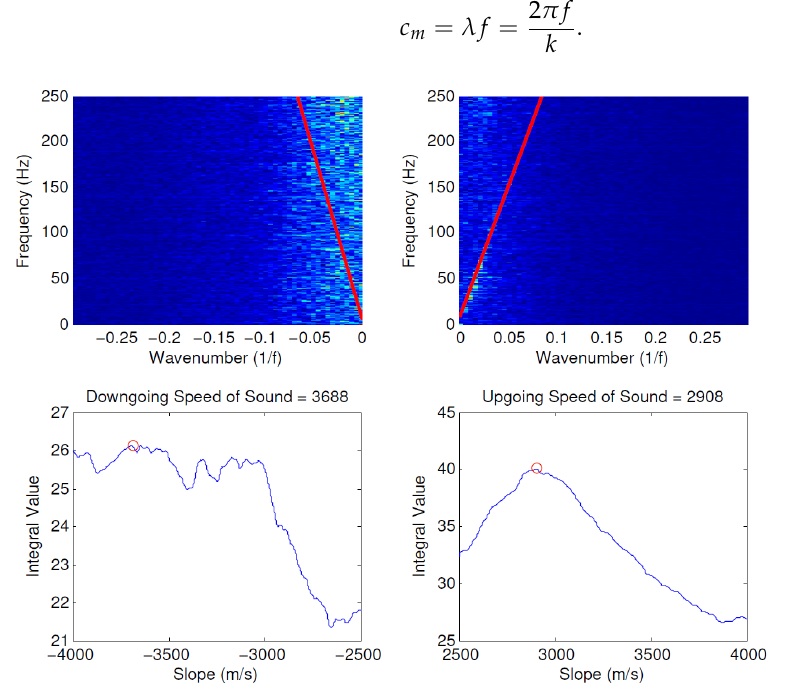
Figure 8. Comparison of the speed of sound between a clear line image ( left ) and not a clear one ( right ). Reprinted from ref.